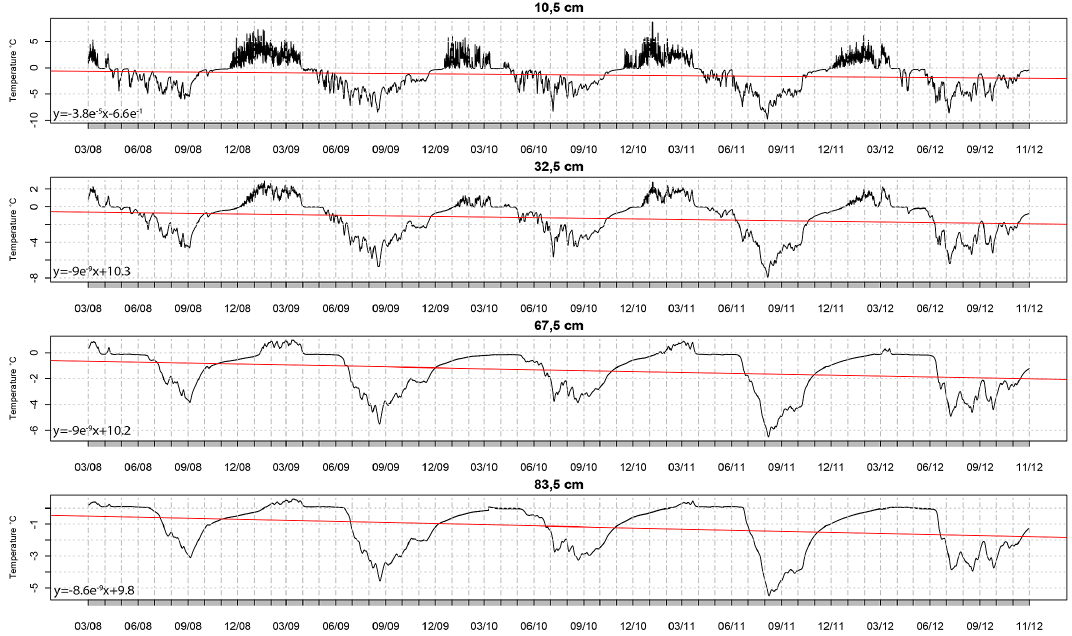
Figure 7. Linear regression for F1, F2, F3 and F4. Table 4. ARIMA order, coefficients sigma squared and log of likelihood for F1, F2, F3, and